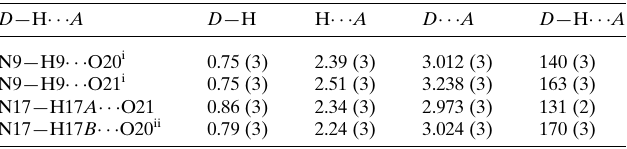
Table 1 Hydrogen-bond geometry (A˚ , (cid:3) ).